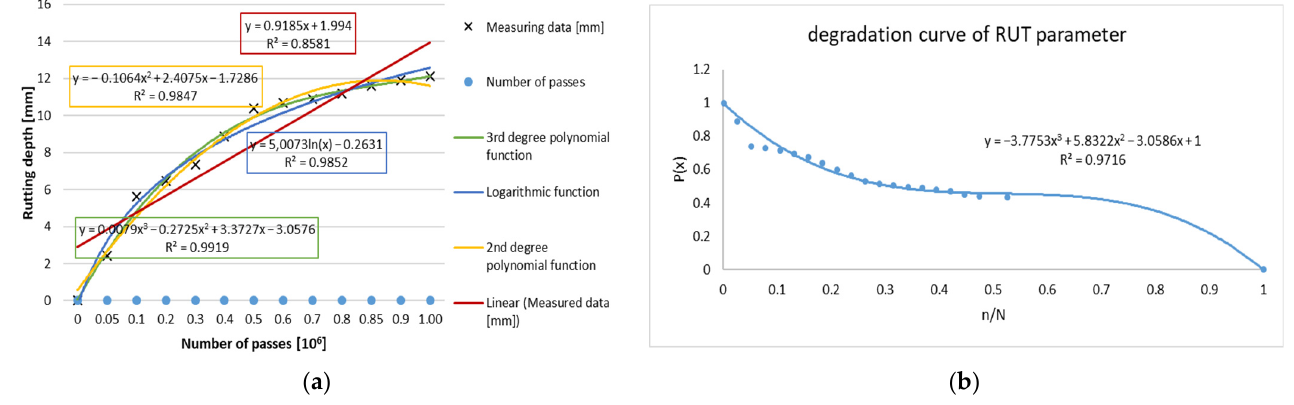
Figure 4. Example of pavement performance model—( a ) graphic evaluation of RUT parameter increase, ( b ) deterioration function of RUT parameter (P) measured on APT facility.